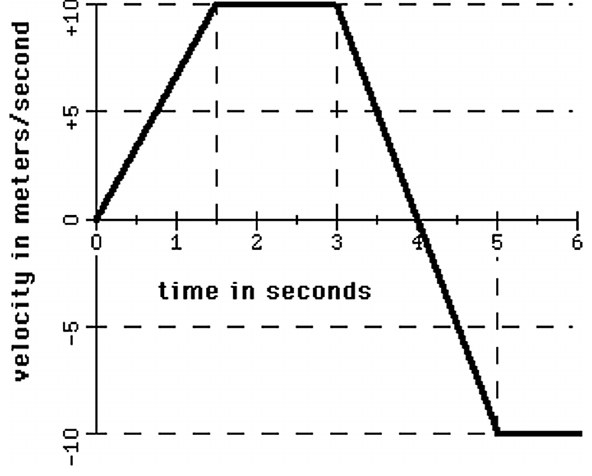
FIG. 5. Graph corresponding to question 5.